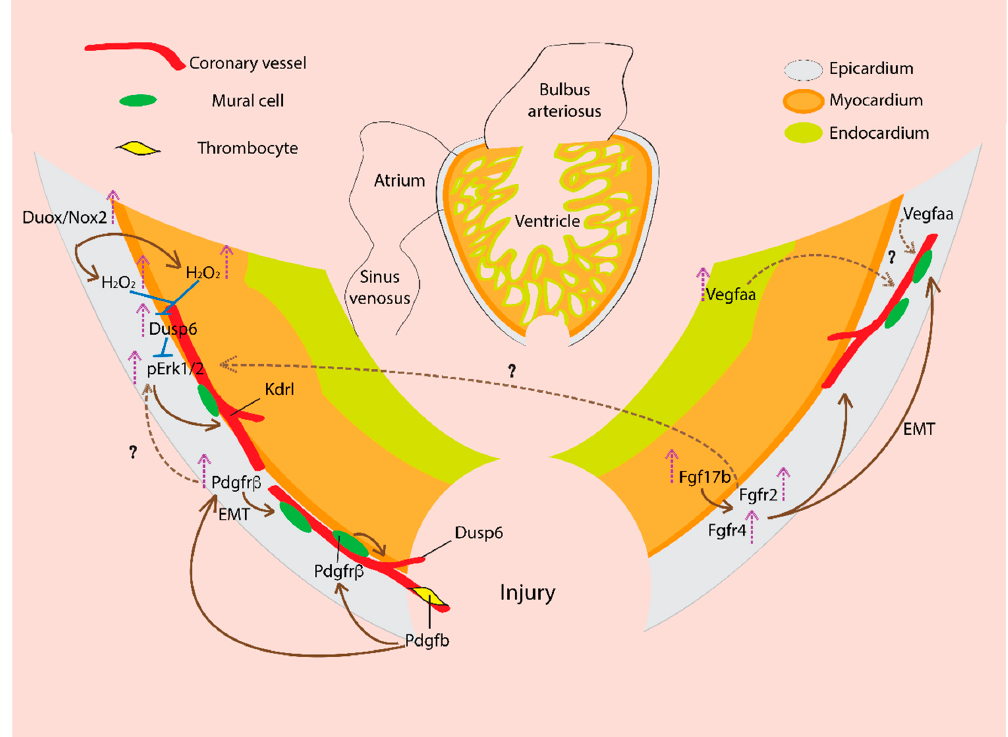
Figure 2. Signaling pathways regulating new coronary vasculature formation during zebrafish heart regeneration. In a regenerating heart, vascular endothelial growth factor (VEGF) ligand, Vegfaa expression increases and is required for coronary vascularization. Vegfaa expresses in the epicardium, and upon injury, Vegfaa expression is upregulated in the endocardium. Fibroblast growth factor (FGF) ligand, Fgf17b expression increased in the myocardium, and the receptor Fgfr2 and Fgfr4 are expressed in the epicardium. FGF activity drives epithelial to mesenchymal transition (EMT) of the epicardial cells, which generate mural cells. In the regenerating heart, FGF signaling promotes neovascularization. Platelet-derived growth factor (PDGF) ligand, Pdgfb is likely expressed by thrombocytes (platelets). Pdgfb activates Pdgfr β the receptor on mural/perivascular cells and drives their recruitment to the growing vessels and thus supports coronary vessel formation. The Pdgfr β expression is upregulated in the injured heart epicardium. PDGF signaling promotes EMT of the epicardial cells, which generate mural cells and contribute to coronary neovascularization. Duox/Nox2 expression increases in the epicardium which generates H 2 O 2 . H 2 O 2 inhibits Dusp6, an inhibitory phosphatase of pErk1/2 MAP kinase and thus increase pErk1/2 activity, which promotes kdrl + coronary vessel formation. The Dusp6 expression is induced in injured heart. Dusp6 expresses in the epicardium, coronary endothelial cells, and myocardium. The nascent coronary vessels in the regenerating area express Dusp6. Dusp6 inhibits pErk, which could act downstream of growth factors like PDGF, FGF. Thus, Dusp6 attenuates pErk mediated growth factor responses in a regenerating heart.